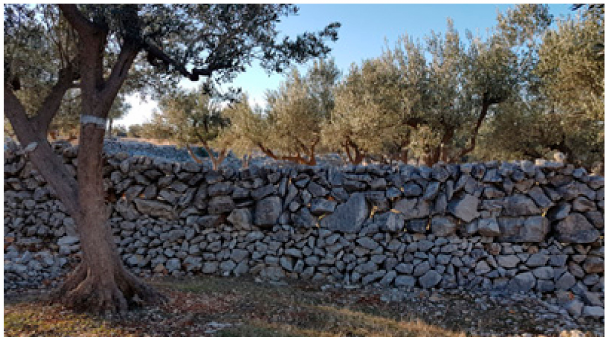
Figure 19. Island of Cres specificity—a dry stone wall of combined construction, composed of both a double and single dry stone wall (Tanja Kremeni´c,